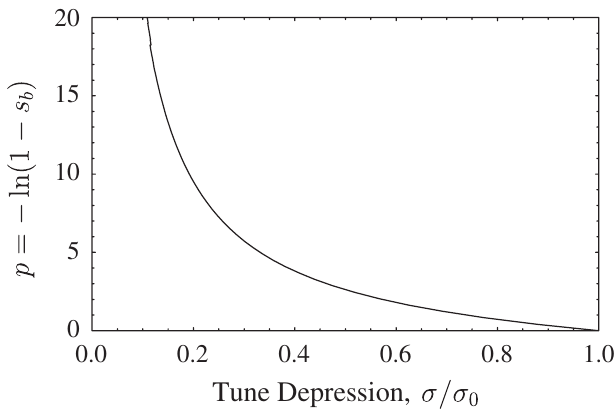
FIG. 14. Parabolic equilibrium parameter p ¼ (cid:1) log ð 1 (cid:1) s versus rms-equivalent beam tune depression (cid:3)=(cid:3) from Eqs. (E26) and (47).